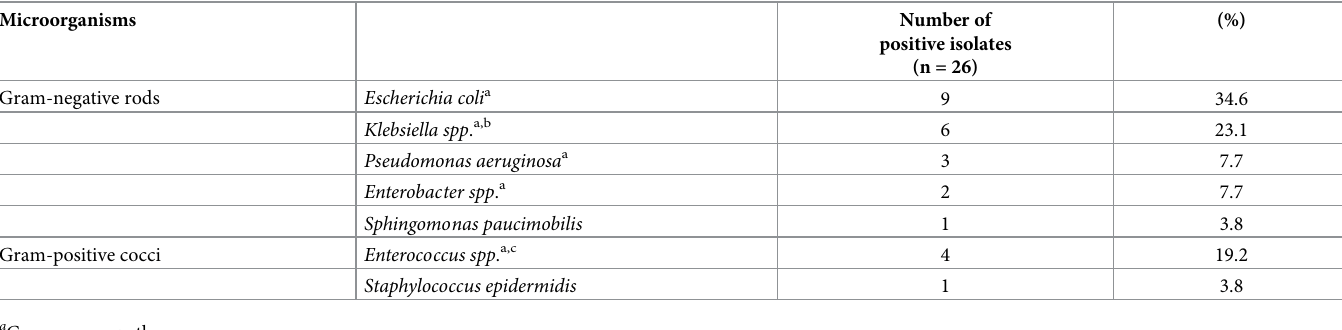
Table 2. Thirty-eight causative microorganisms isolated from urine during the first early urinary tract infection episodes in 37 cases after renal transplantation.